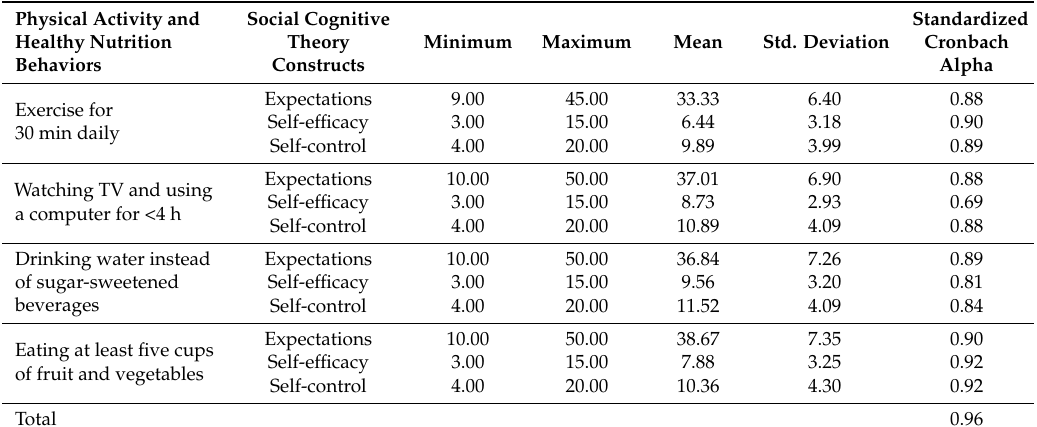
Table 2. Social cognitive theory constructs of physical activity and healthy nutrition behaviors in undergraduate students in Chongqing, China, 2015.